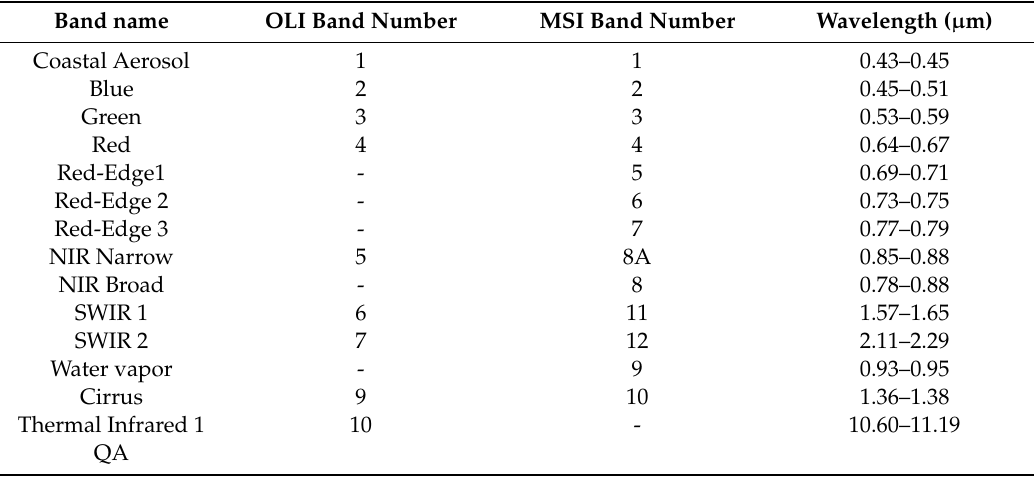
Table 1. Harmonized Landsat Sentinel (HLS) product spectral bands. Table was adapted from